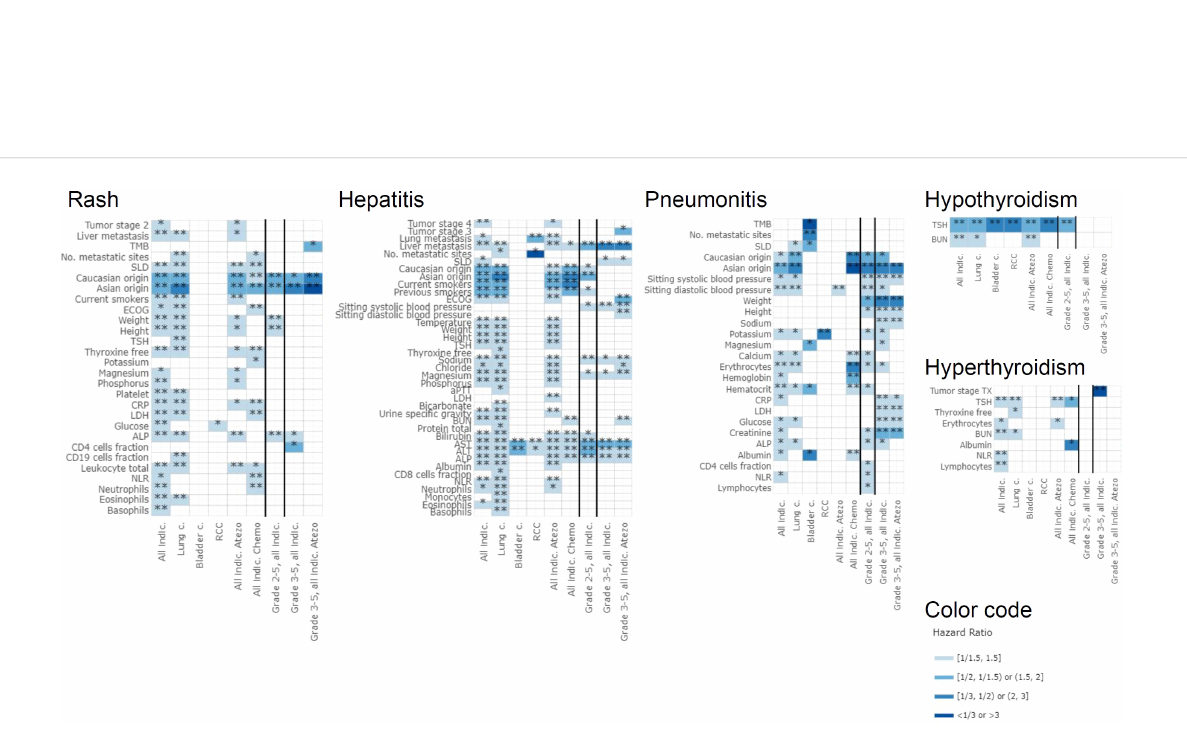
FIGURE 1 For the patients with irAEs the proportion of irAEs by toxicity grade are shown for each treatment arm (row panels) and indication (column panels), together with the total number of events per arm and indication (N). Toxicity grade data is not available for the POPLAR study (NSCLC).